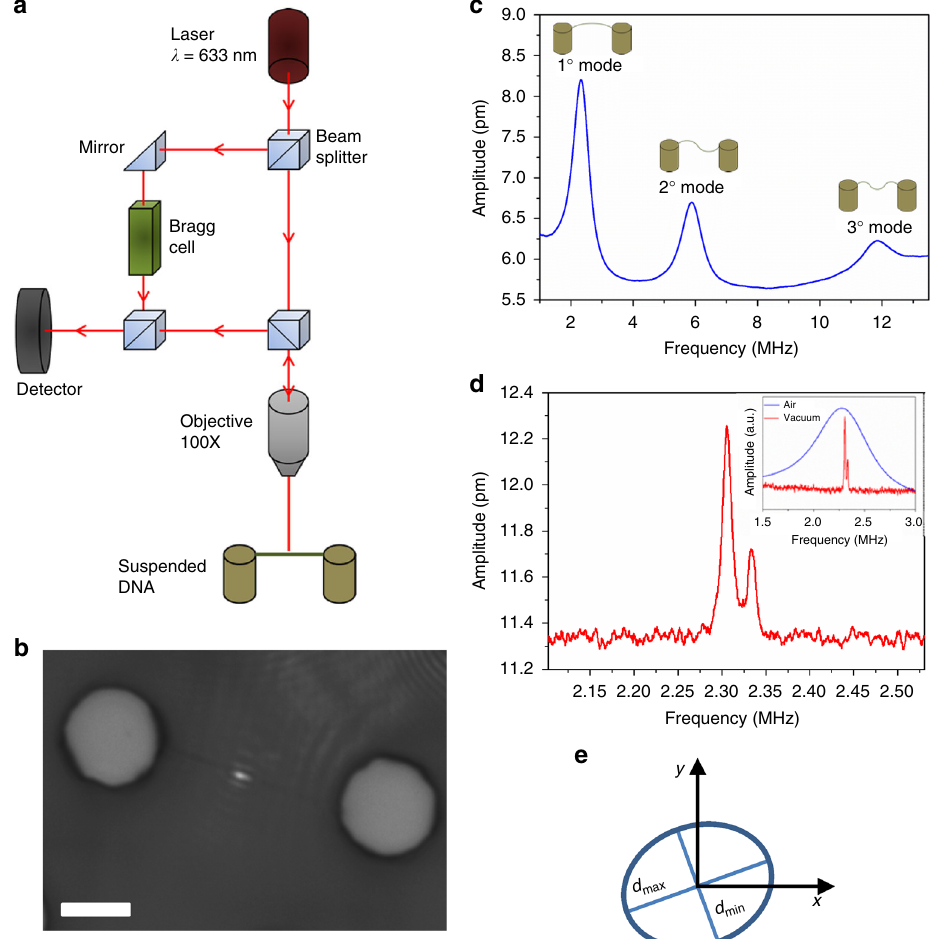
Fig. 5 Nanomechanical characterization of suspended DNA bundles. a Scheme of the experimental setup composed of the Laser Doppler Vibrometer system. b Optical image of the device under test, showing the laser focused on a DNA bundle suspended between two adjacent pillars. The scale bar corresponds to 5 µ m. c Vibration spectra of a DNA resonator measured in air, showing the fi rst three resonance modes. A sketch of the mode shape is reported for each resonance. d Vibration spectra of a DNA resonator measured in vacuum, showing the splitting of the fundamental mode into two peaks. The splitting is due to the motion on the two orthogonal directions related to the axis of the maximum ( d max ) and minimum ( d min ) of the cross-section diameter. In the inset, the difference between the fundamental mode measured in air and vacuum can be clearly seen. e Schematic of the elliptical cross section of the DNA resonator. The variation between maximum ( d max ) and minimum ( d min ) of the cross-section diameter is exaggerated for a better understanding